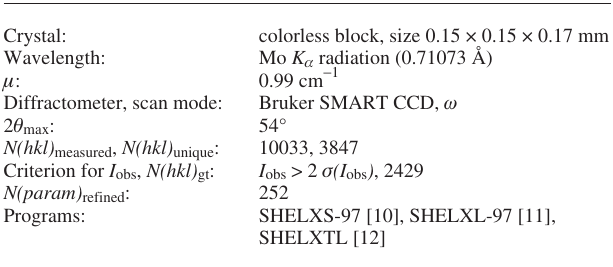
Table 1. Data collection and handling.